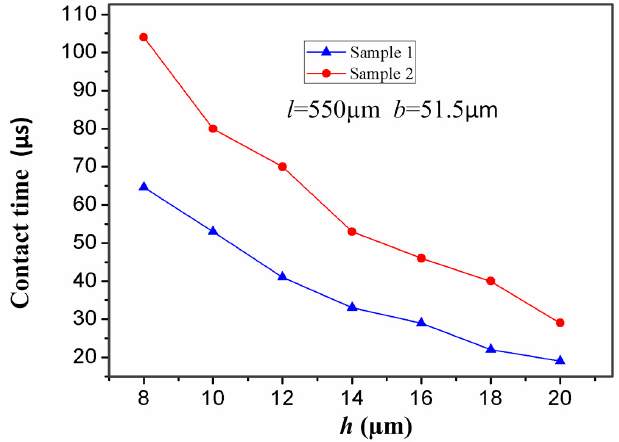
Figure 8. Dependence of contact time in samples 1 and 2 on the thickness ( h ) of the stationary electrode under the applied acceleration 288 g.